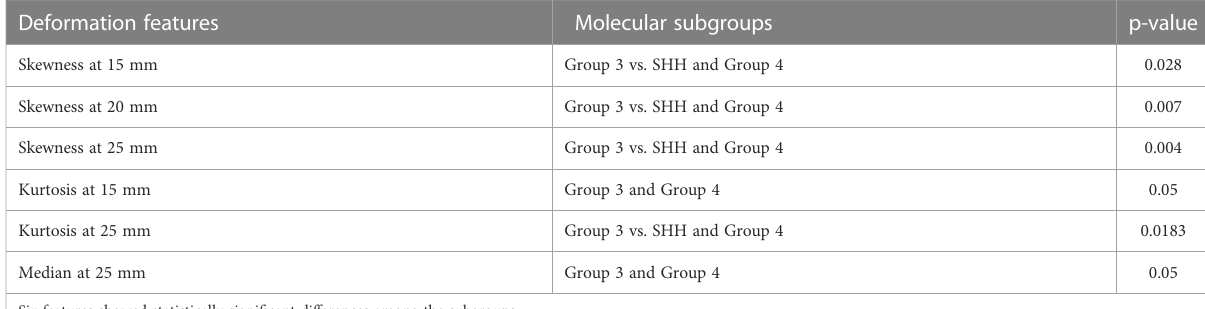
TABLE 2 ANOVA results for identifying the four molecular MB